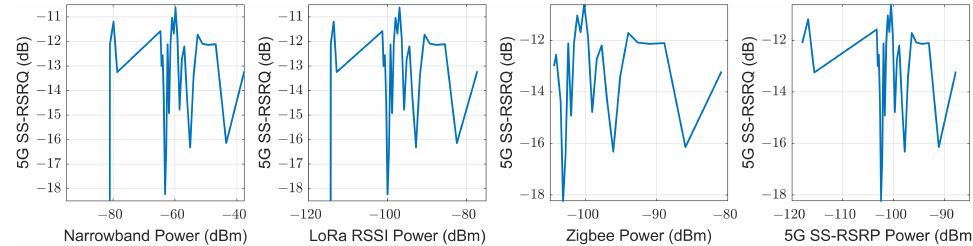
Figure 17. Comparison of empirical 5G SS-RSRQ with the estimated received power for each